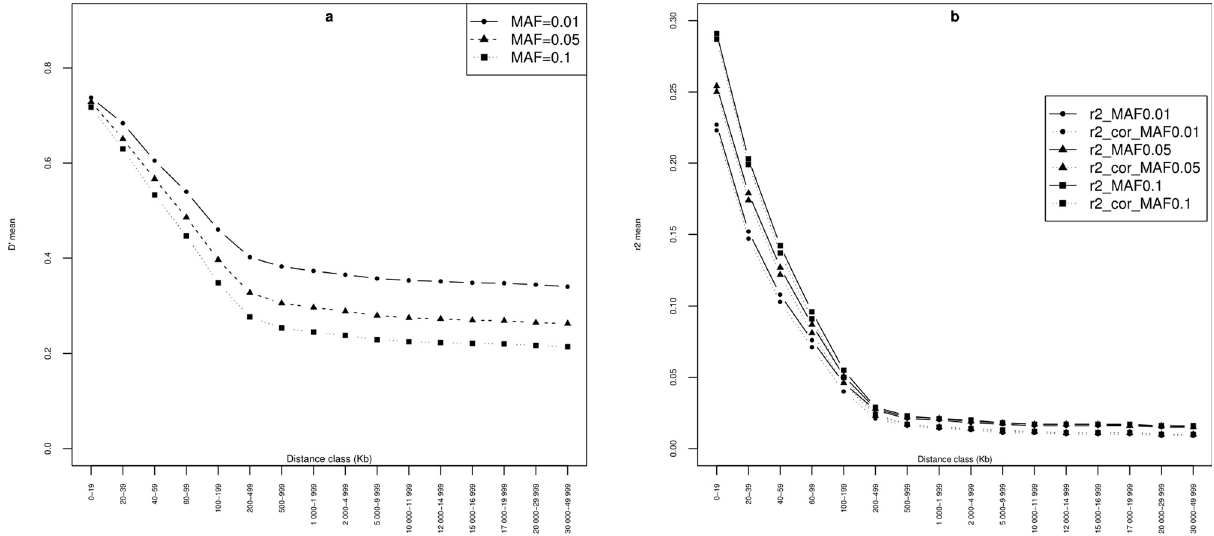
Figure 1 - Average LD decay pooled over all autosomes for three different minor allele frequency (MAF) thresholds in the Tunisian cattle population: (a) D’ , (b) r 2 (as estimated by Haploview) and r 2 corrected for sample size ( r 2